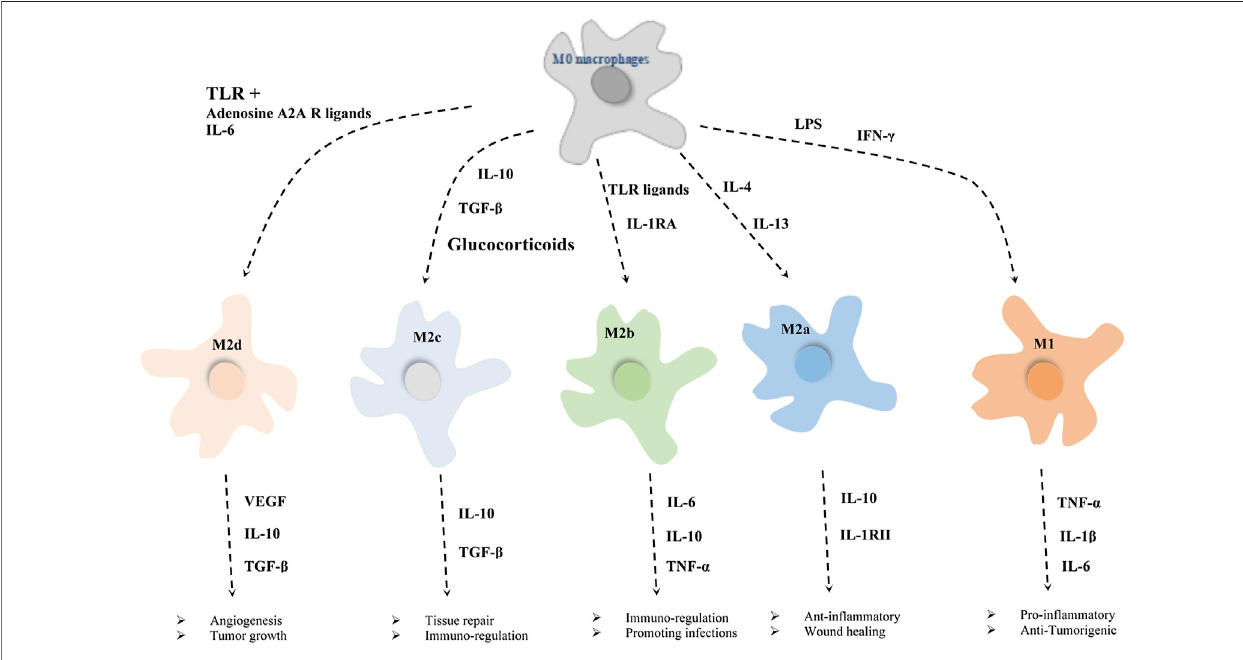
FIGURE 3 | Different exogenous factors induce the direction of macrophage polarization and the roles of different macrophages in various processes (Ping et al., 2021).